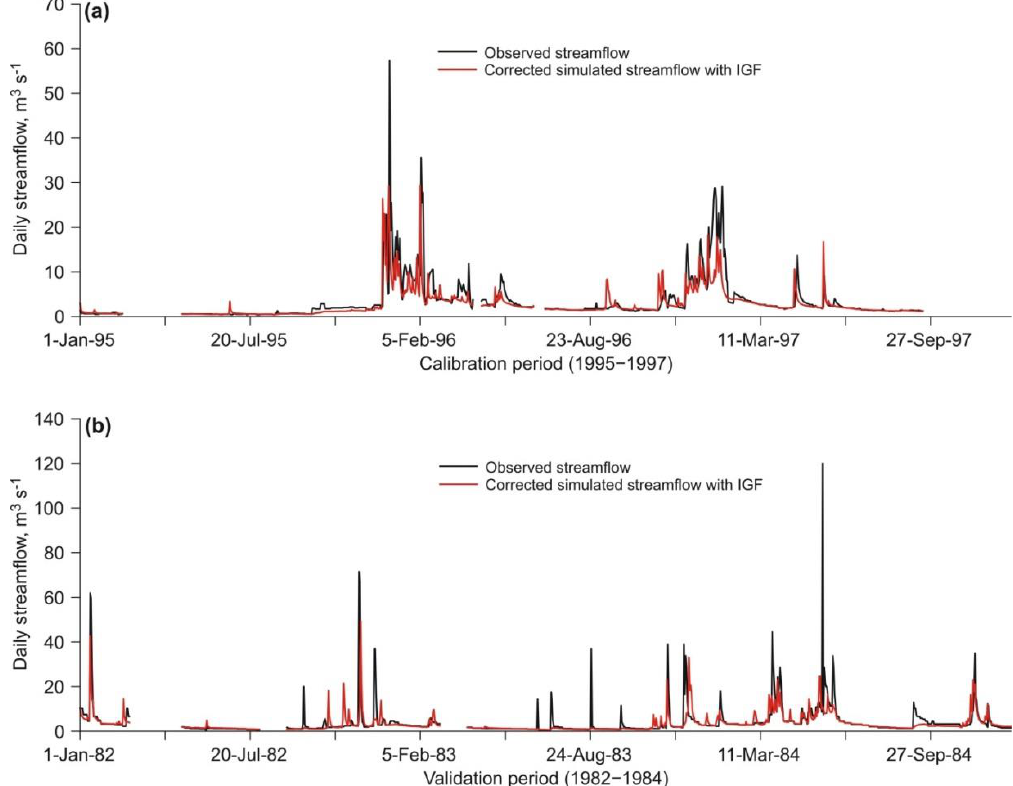
Figure 8. On a daily scale, observed streamflow compared to corrected simulated streamflow with SWAT model for the ( a ) calibration and ( b ) validation phases.